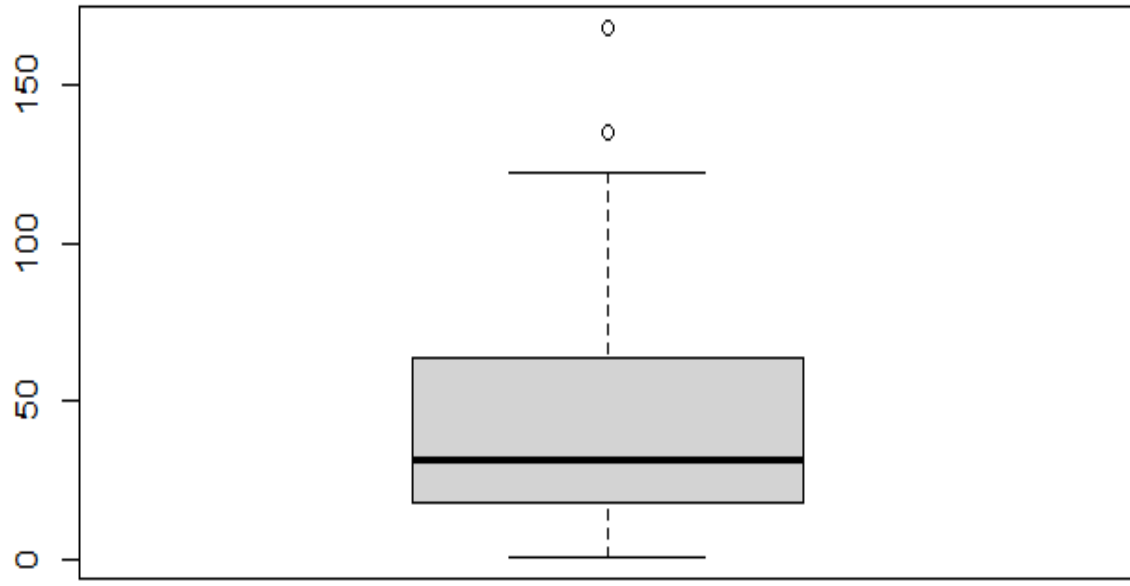
Figure 3. Outliers in a boxplot.